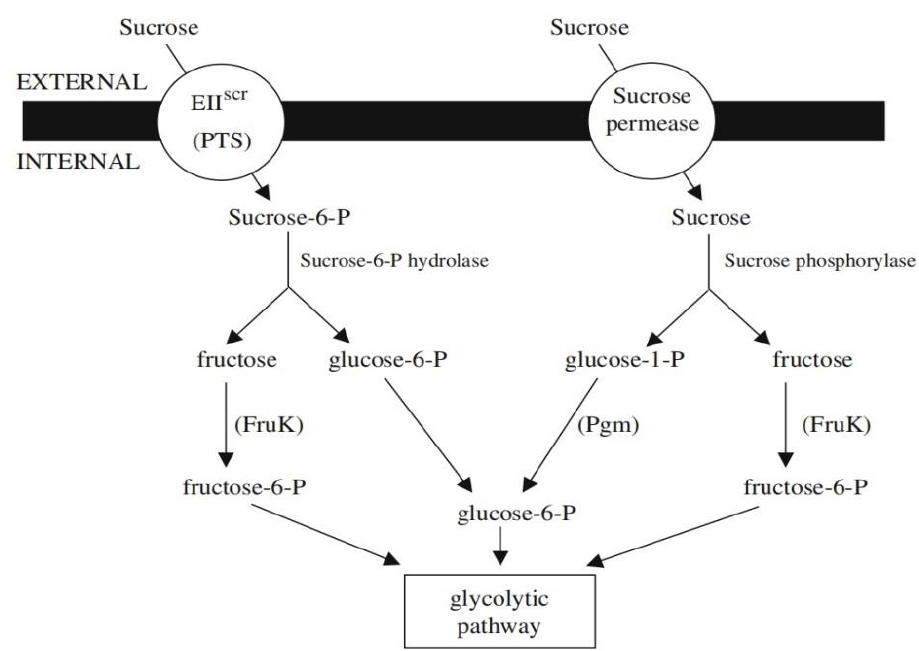
Figure 5. Sucrose metabolism producing intermediates for glycolytic pathway. Adapted with permission from Shanton and Valerie, [145]).